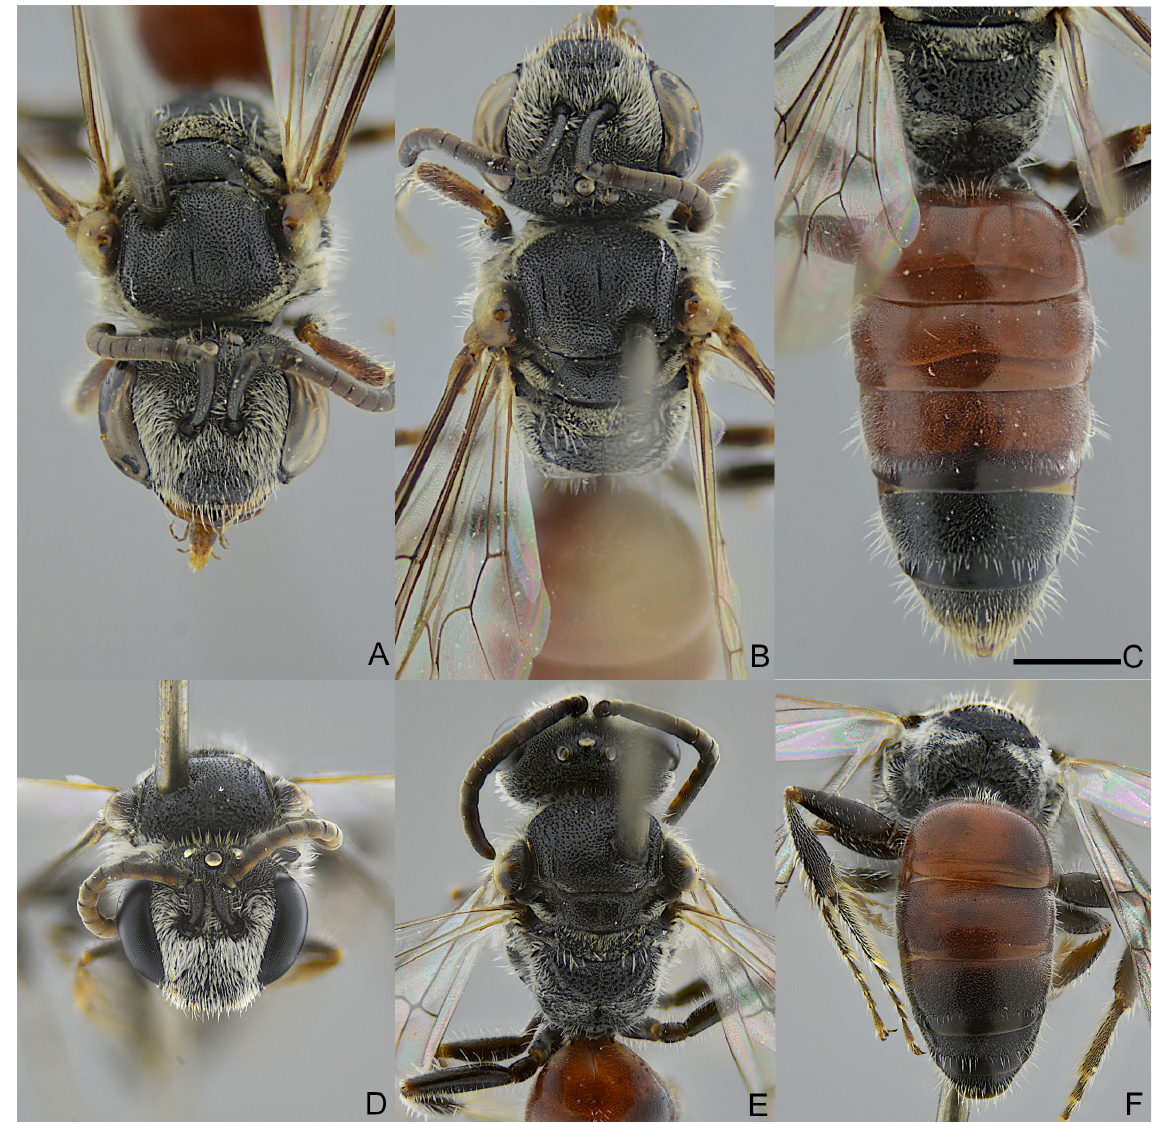
Fig. 7. Austrosphecodes lucifer sp. nov. A – C . Holotype, ♀ (DZUP 568517). D – F . Paratype, ♂. A . Female head. B . Female mesosoma. C . Female propodeum and metasoma. D . Male head. E . Male mesosoma. F . Male metasoma. Scale bar = 1